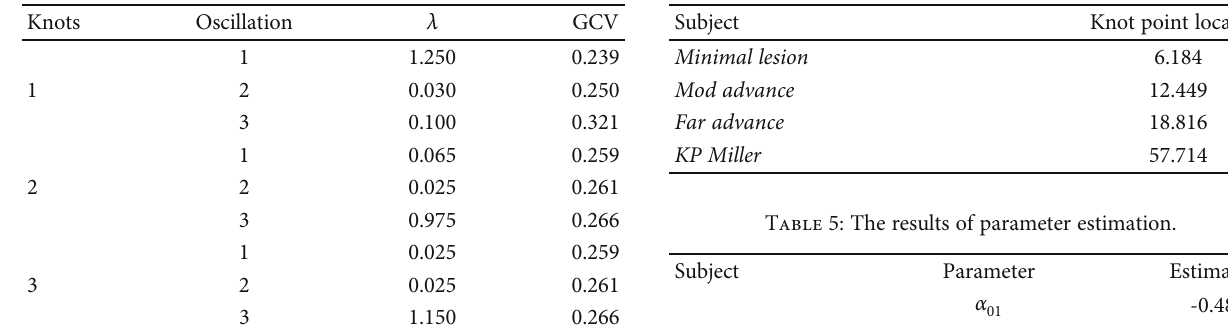
Table 4: Knot point location for each subject. Table 3: Summary of case study results.